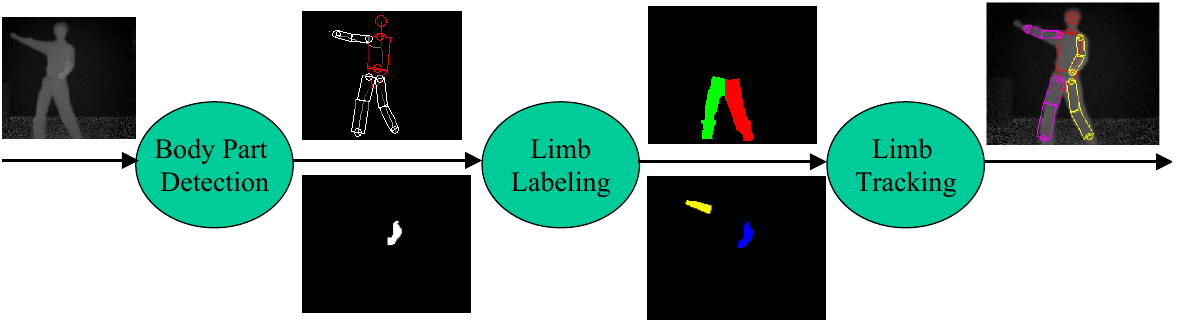
Figure 5. Body part detection, labeling and tracking.